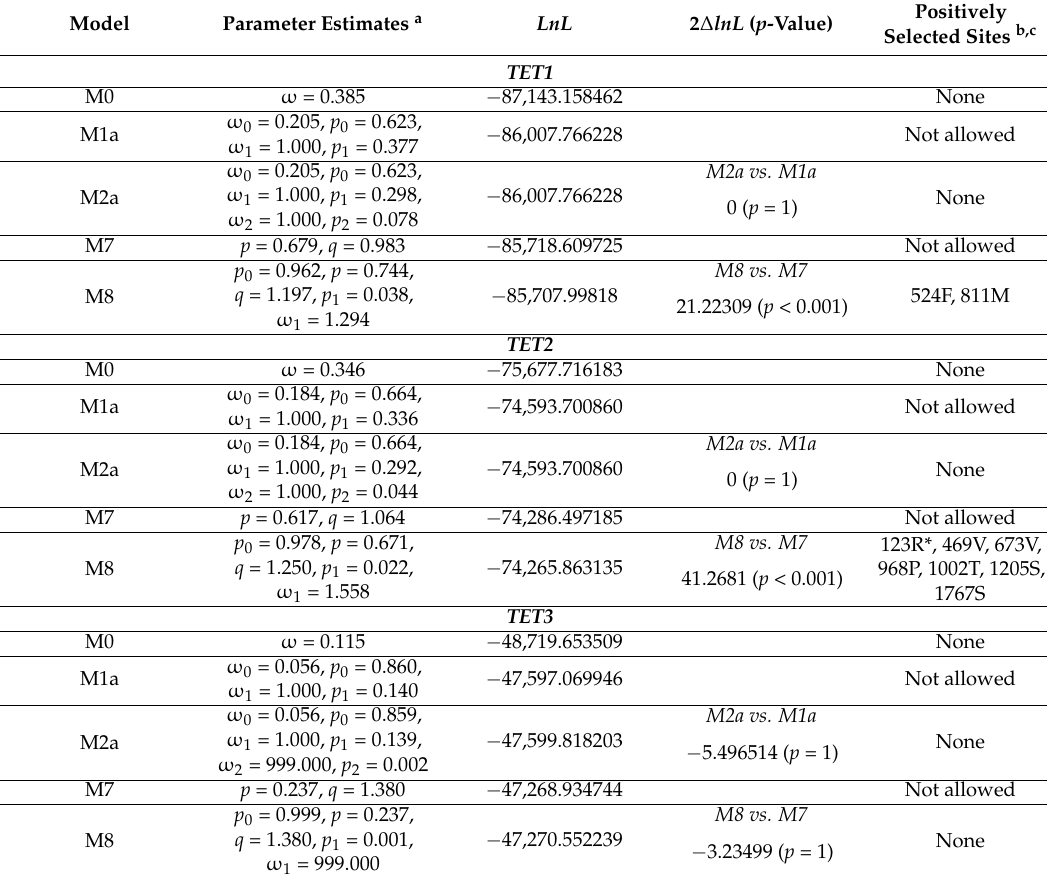
Table 1. Likelihood analysis of the site models in the PAML program for the TET gene sequence